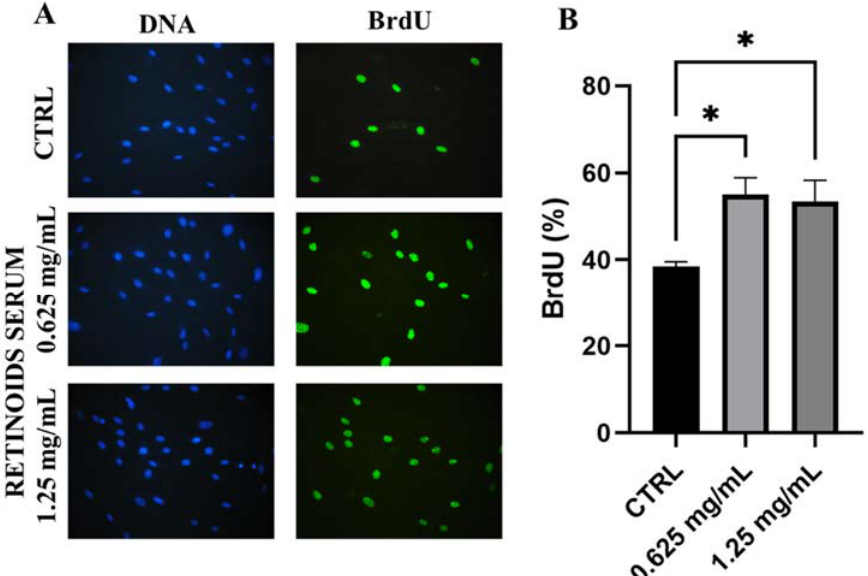
Figure 2. Representative images of immunofluorescence BrdU assay ( A ) DNA is marked in blue with Hoechst 33258 while BrdU is visible in green. ( B ) Quantitative assessment of BrdU positive cells expressed as a percentage (mean ± SD) compared to control after 24 h of treatment with the RETINOIDS SERUM (0.625 and 1.25 mg/mL). Values of * p < 0.05 were considered statistically sig- nificant compared to untreated cells (CTRL).